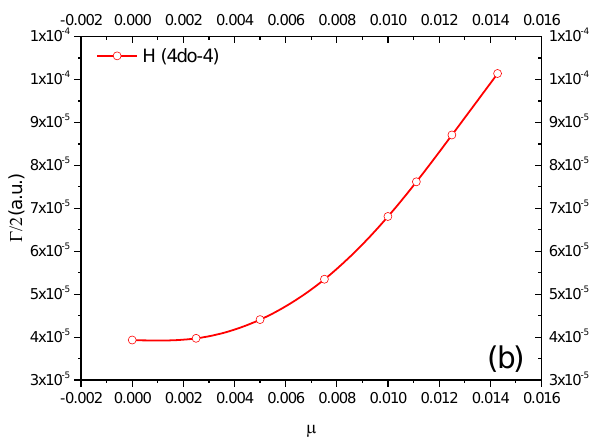
Figure 10. D -wave states with unnatural parity: ( a ) resonance energy and ( b ) half-width for the H(4d°-4) state as a function of μ = 1/ D . Table 3. D -wave resonances with unnatural parity in the positron-hydrogen system with various Debye lengths D . The threshold energies E T are associated with the excited nd states of the parent (H or Ps) atom. The notation A(−B) denotes. A × 10 −B . Units are in a.u.